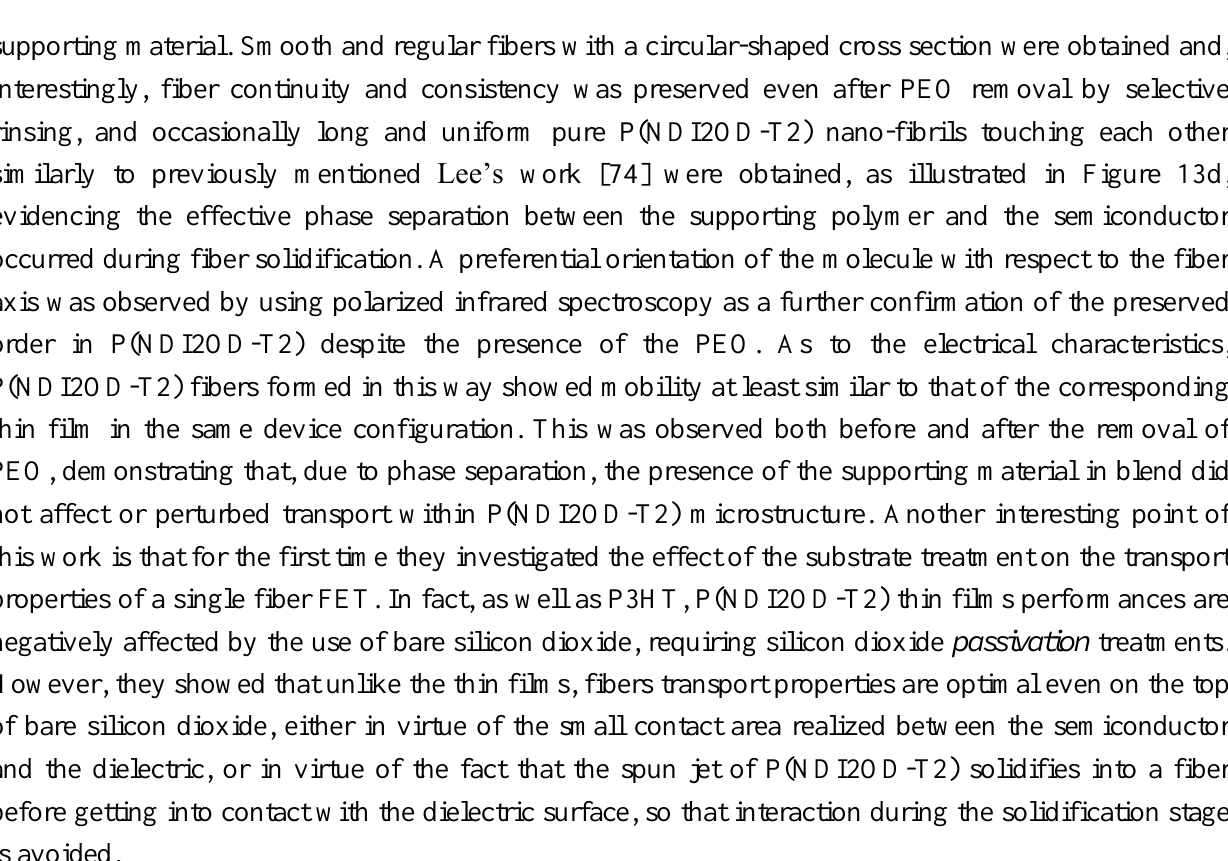
Figure 13. SEM images of P(NDI2OD-T2)/PEO fibers: the relative content of the two polymers is equal to ( a ) 70:30 mass/mass (w/w); ( b ) 70:30 w/w, upon rinsing with acetonitrile; ( c ) 50:50 w/w; ( d ) 50:50 w/w, upon rinsing with acetonitrile and ( e ) transfer curves of single fiber (continuous lines) and thin film (dashed lines) P(NDI2OD-T2) FETs (channel length of 20 µm); the characteristics of devices on both bare SiO and OTS treated dielectric layers (red lines) are reported; a drain voltage of 100 V was applied during all the measurements; in the plot, drain current values are normalized to the channel width, which in the case of the fiber was conservatively assumed to be equal to its